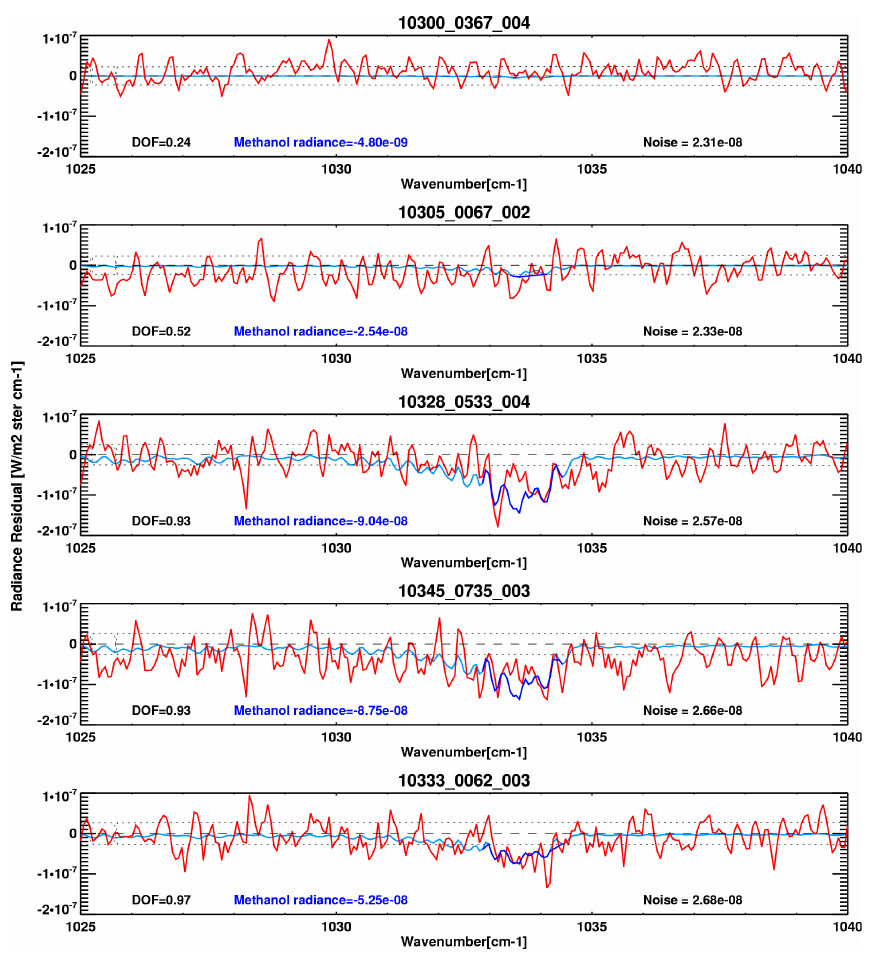
Fig. 8. Methanol spectral signal in the TES observations. Shown are sample differences between measured TES spectra and forward model runs with no methanol (red curves), and the corresponding differences between forward model runs with retrieved methanol and no methanol (light blue curves). The methanol radiance is the mean of the latter over the spectral range highlighted in dark blue. The dotted lines indicate the expected noise